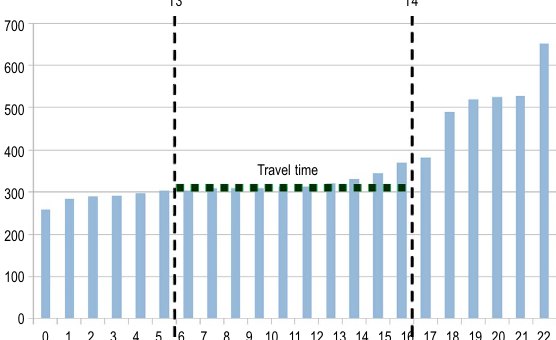
T2 Fig. 5. Sample of trip starts and trip ends (and their boundaries)